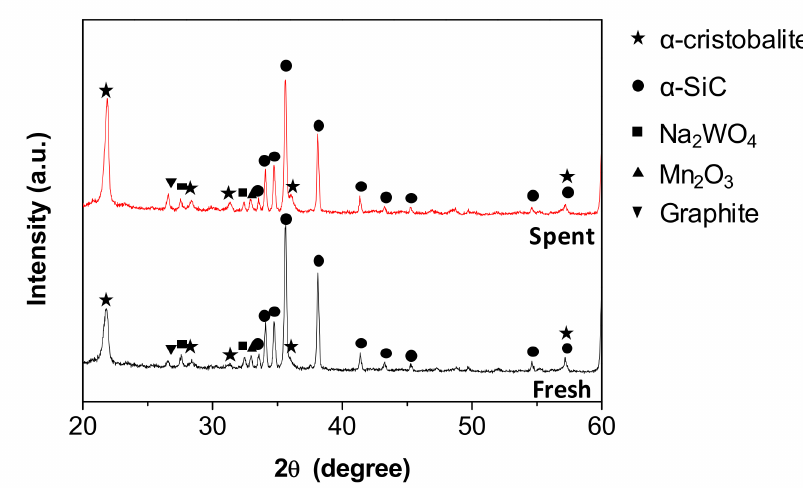
Figure 6. X-ray di ff raction patterns for the fresh and spent MNW / m-SiC samples. The reaction conditions are same as described in Figure